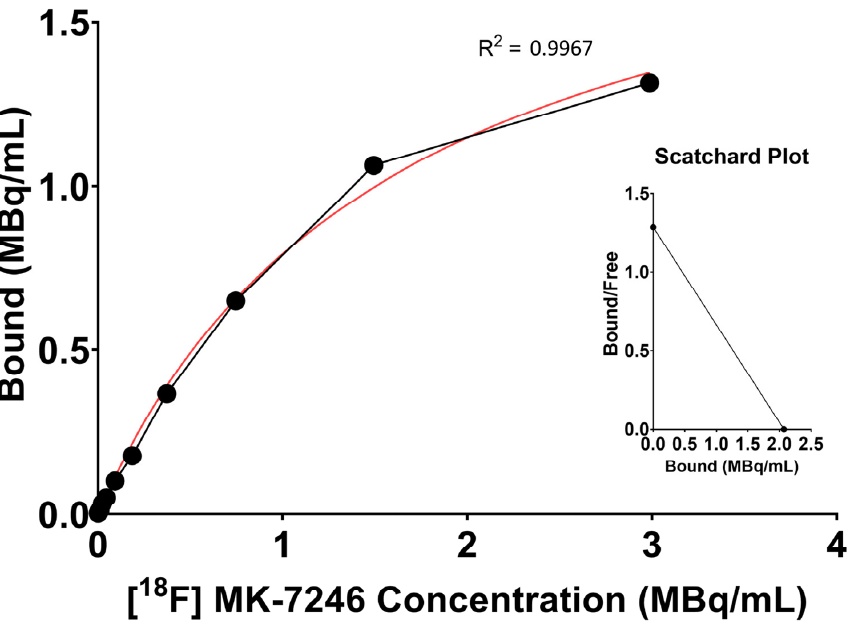
Figure 3. Representative saturation binding curve and Scatchard plot calculated from the binding of [ 18 F]MK-7246 to GPR44-expressing cells using the one-site-specific-binding-nonlinear-fit function of Graphpad Prism (average value of n = 15).